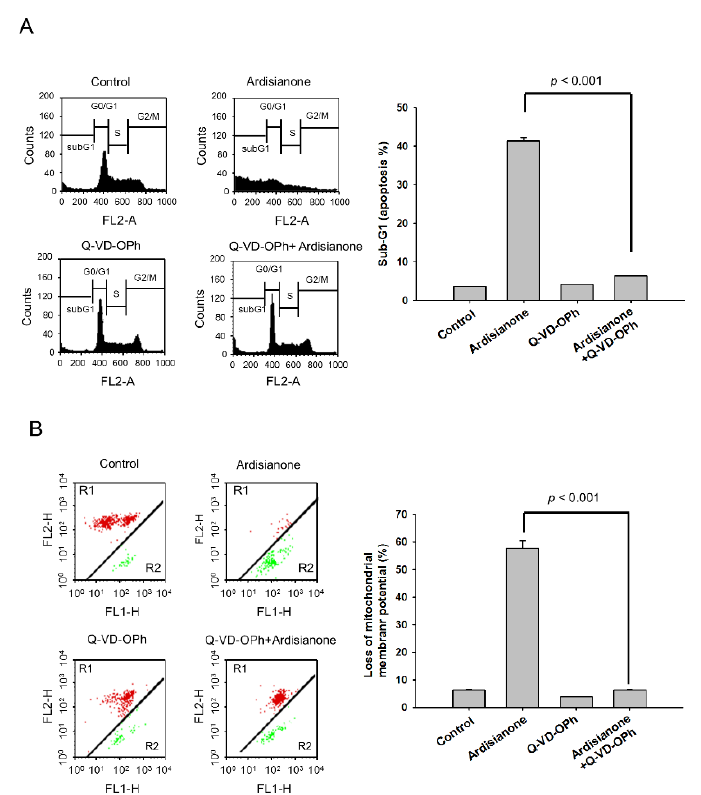
Figure 4. Effect of Q-VD-OPh on ardisianone-induced apoptosis and loss of mitochondrial membrane potential. HL-60 cells were treated in the absence or presence of the indicated agent (ardisianone, 2 μM; Q -VD- OPh, 20 μM) for 24 h. After the treatment, the cells were fixed and stained with propidium iodide to analyze DNA content ( A ) or incubated with JC-1 for the detection of mitochondrial membrane potential using flow cytometric analysis ( B ).